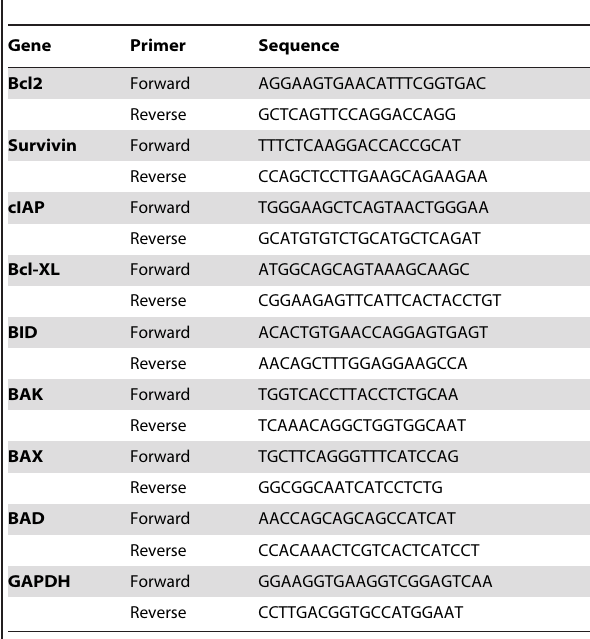
Table 1. Pro- and anti-apoptotic primer sequences used for